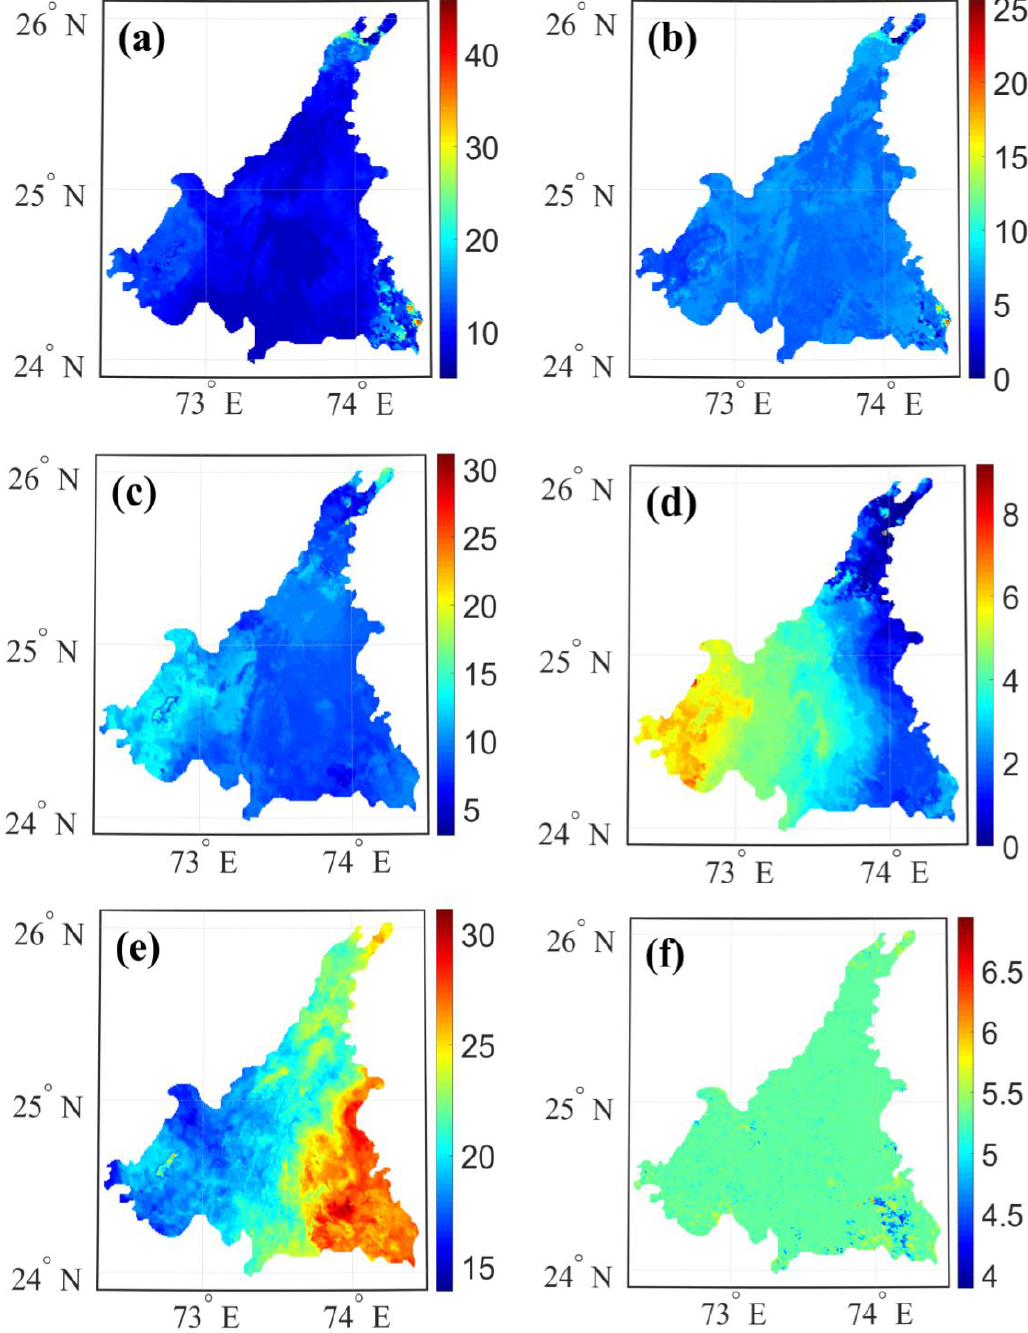
Figure 6. Drought duration maps for each Coupled Model Intercomparison Project Phase 6 (CMIP6) scenario for study area AV. ( a , b ) for SSP1-2.6; ( c , d ) for SSP2-4.5; ( e , f ) for SSP5-8.5. ( a , c , e ) for severe drought and (b,d,f) for extreme drought. The scale bar represents months of drought in 30 years (2015 – 2044).